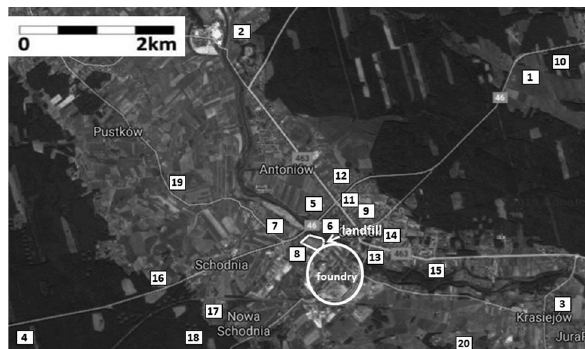
Figure 3: Location of soil sampling points. Source: www.google.